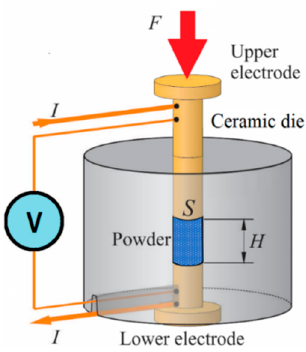
Figure 2. Scheme of experimental device used to determine the conductivity vs. porosity curve of a powder mass under pressure.